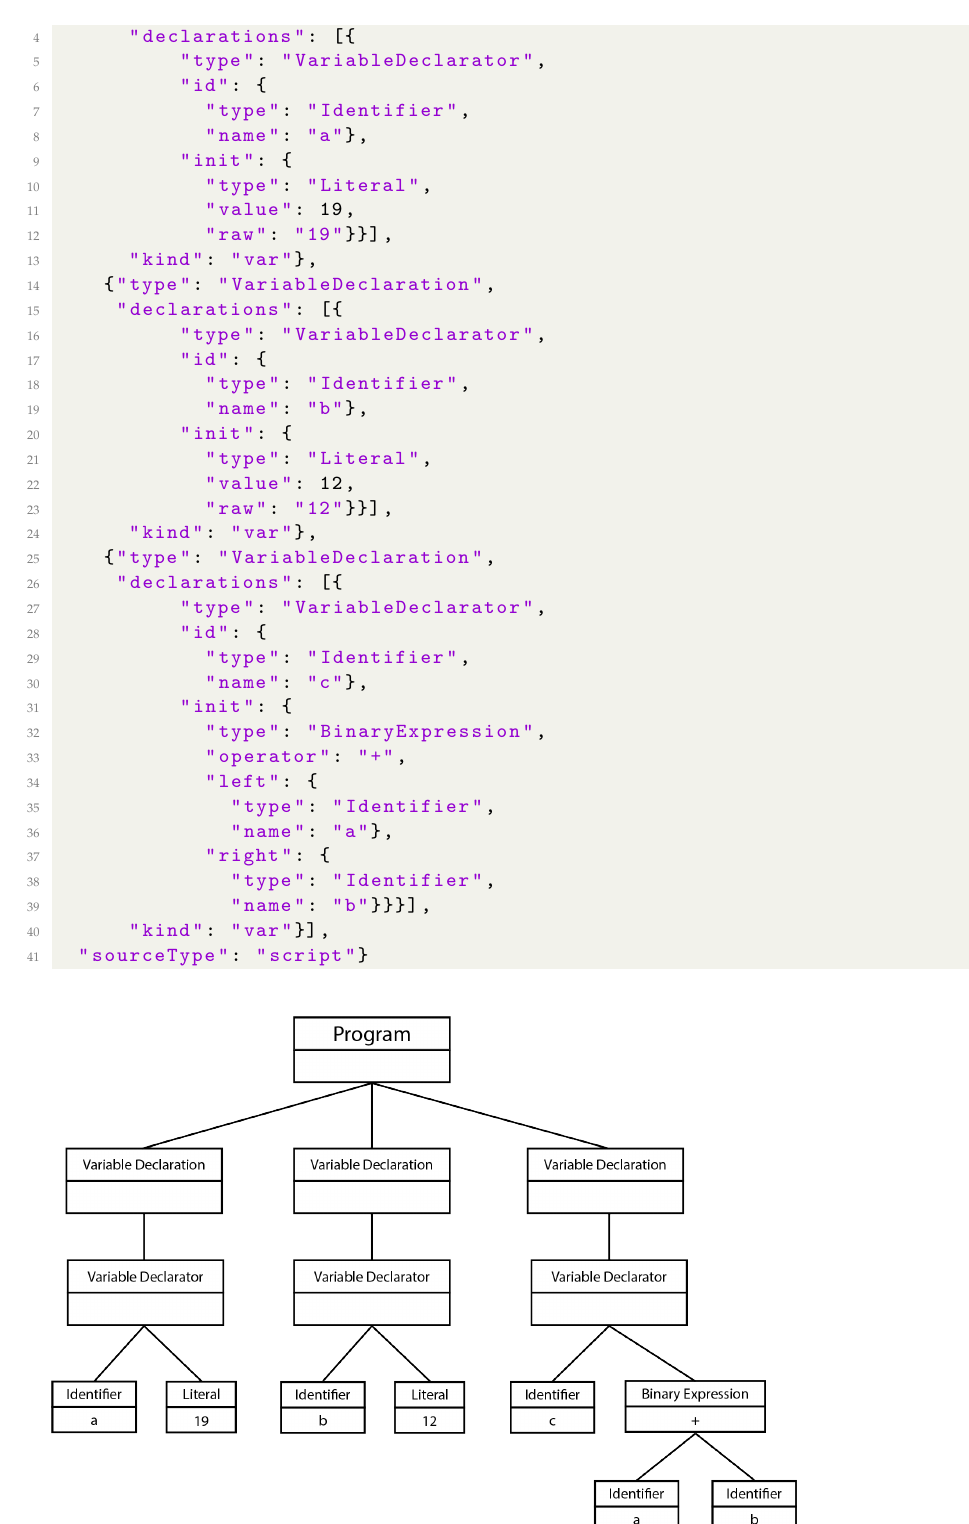
Figure 2. Visualization of an AST structure as a